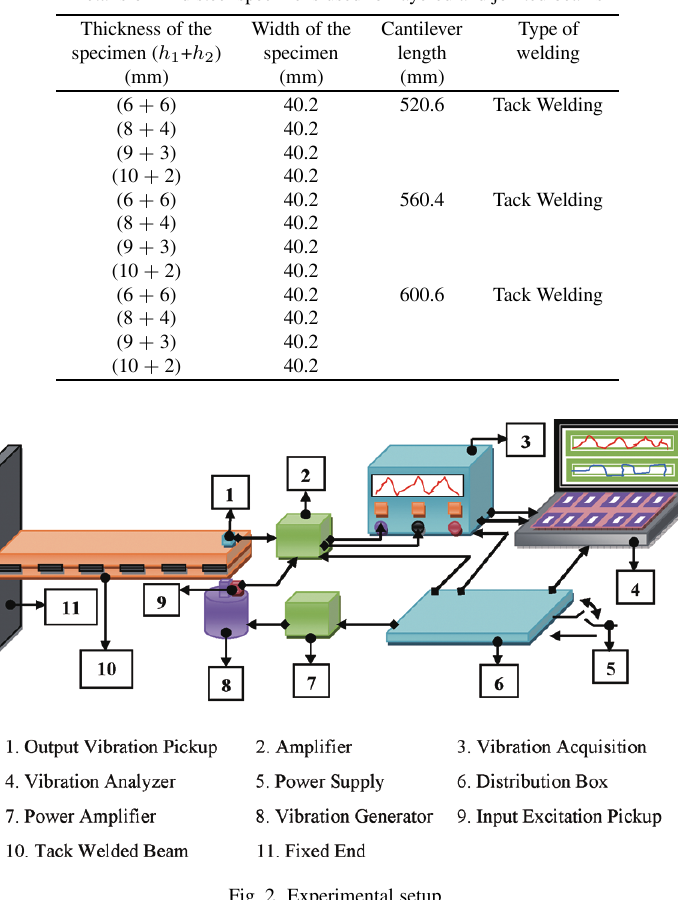
Table 1 Details of mild steel specimens used for layered and jointed beams